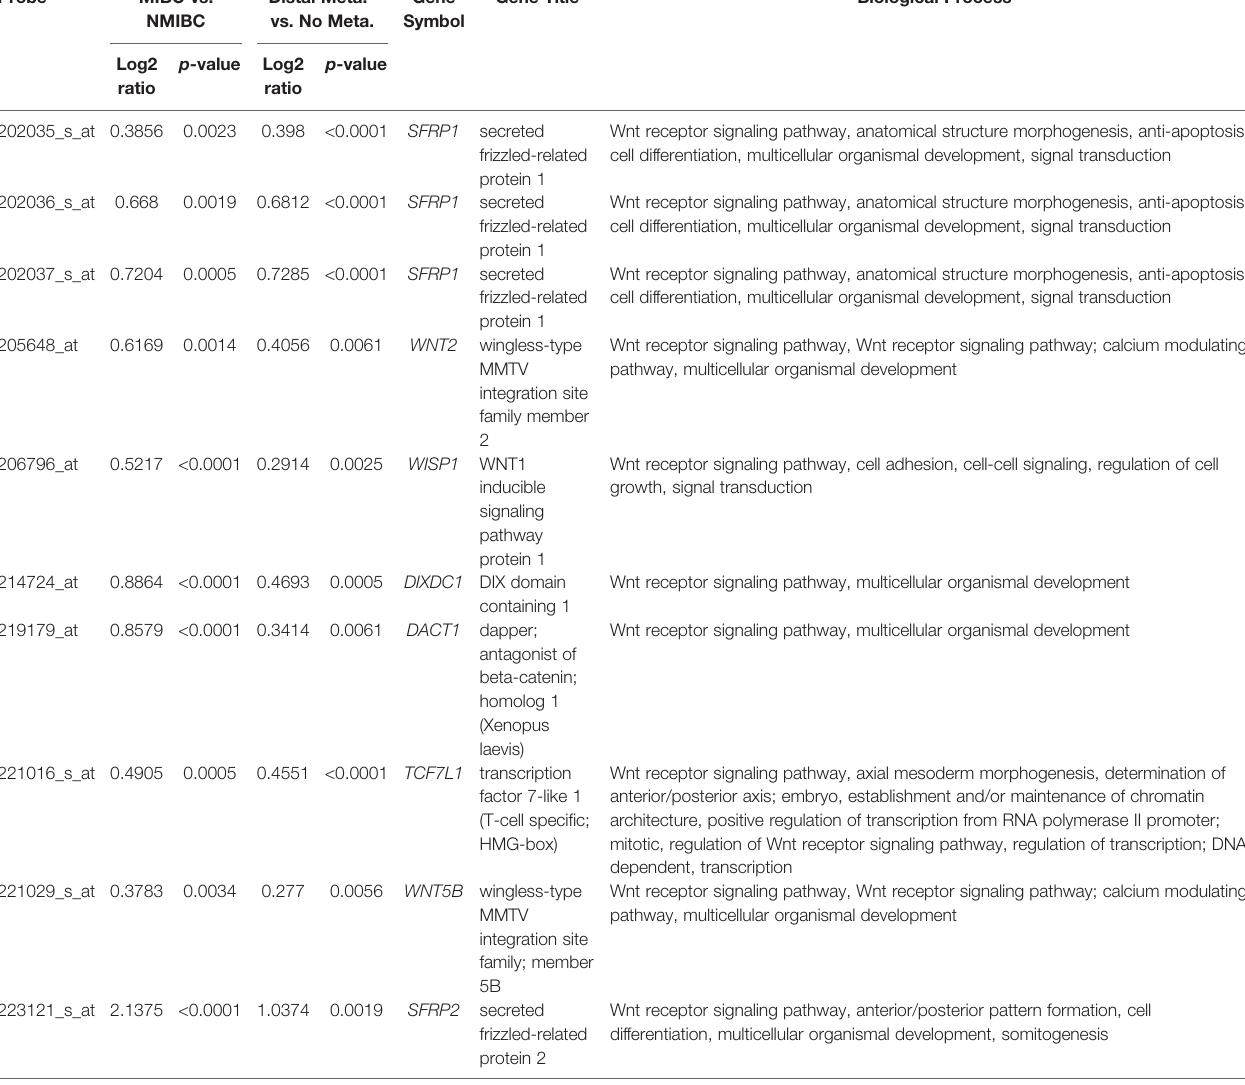
TABLE 1 | Summary of 8 signi fi cantly altered genes associated with the Wnt signaling pathway (GO: 0016055) and UC invasion and metastasis (GSE31684).